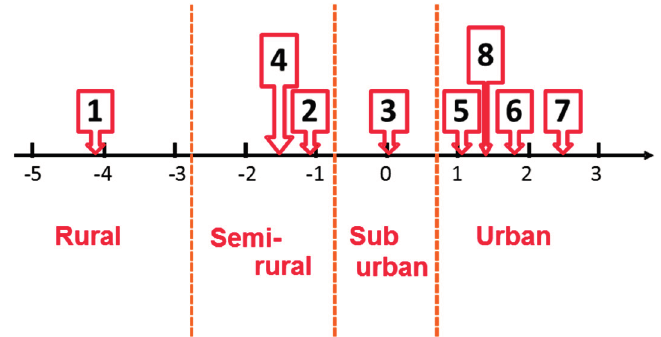
Figure 2. Plot of first principal component score of eight clusters and re-grouping into four